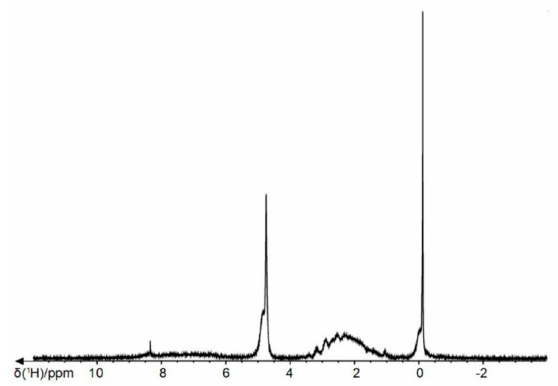
Figure 9. The 1 H-NMR spectrum of synthetic